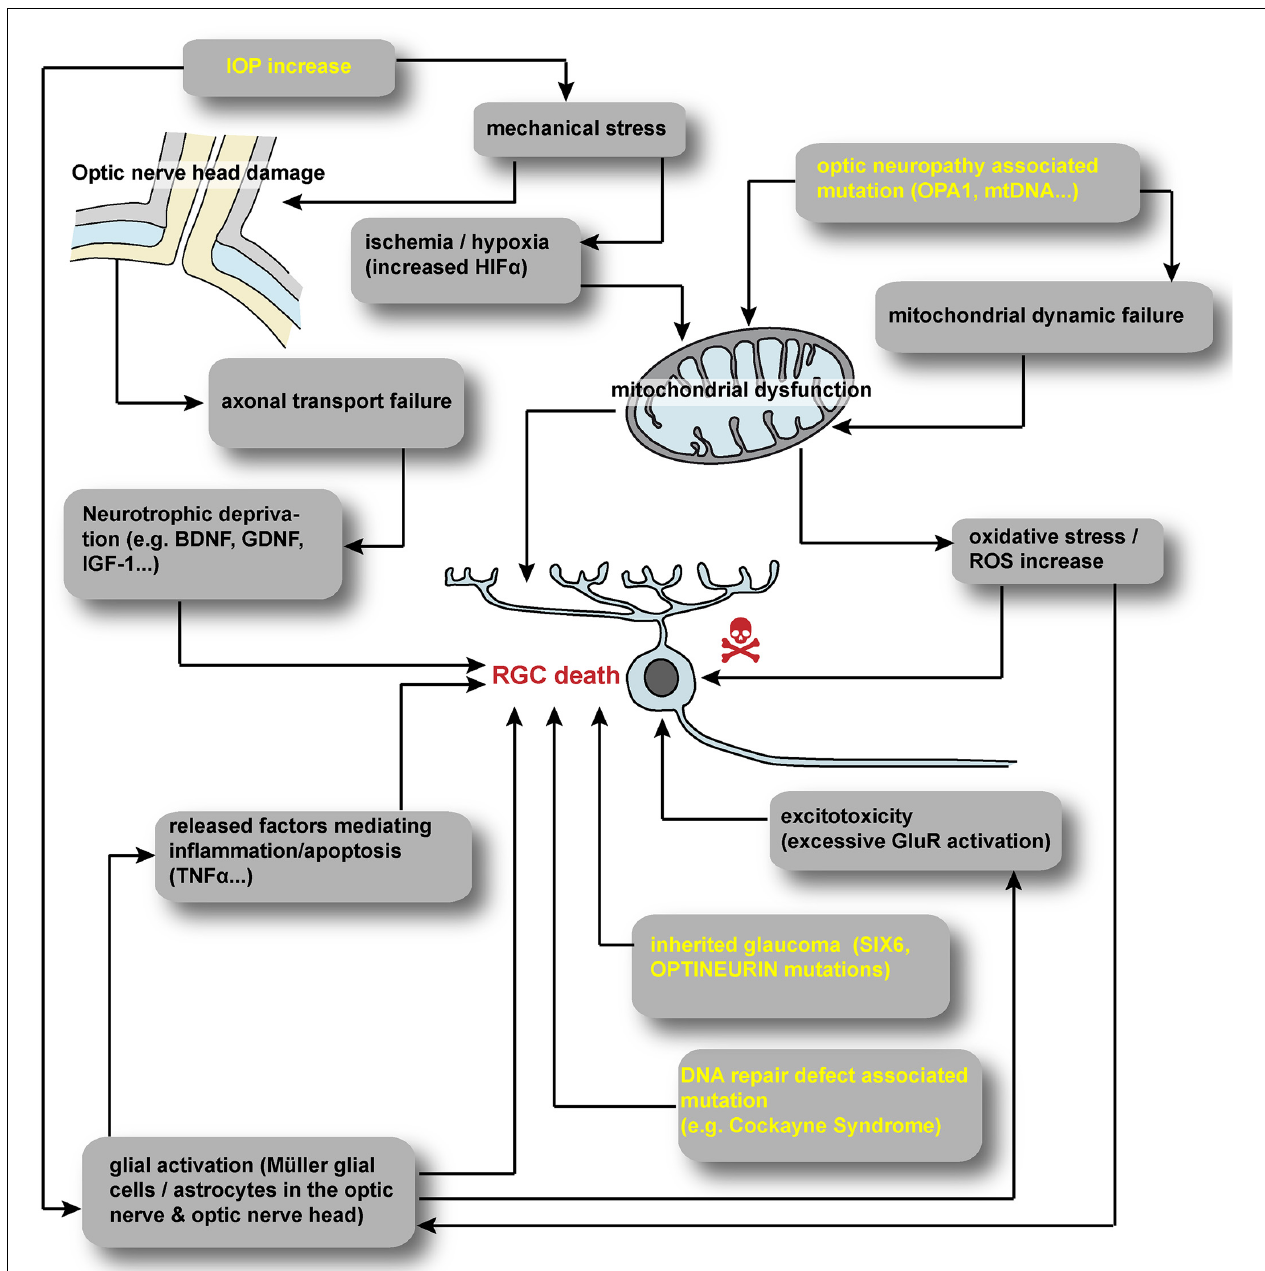
FIGURE 1 | Summary of hypothesized scenarios of RGC degeneration. A vast number of extrinsic and intrinsic cues have been reported to trigger RGC degeneration. Increased IOP in glaucoma may induce mechanical stress at the optic nerve head leading to hypoxia and axonal transport defect. Inherited optic neuropathies often involve directly or indirectly mitochondrial defect. In all RGC disorders, glial cells are suspected to contribute to RGC degeneration. IOP, intraocular pressure; HIF, hypoxia inducible factor; ROS, reactive oxygen species; mtDNA, mitochondrial DNA; GluR, glutamate